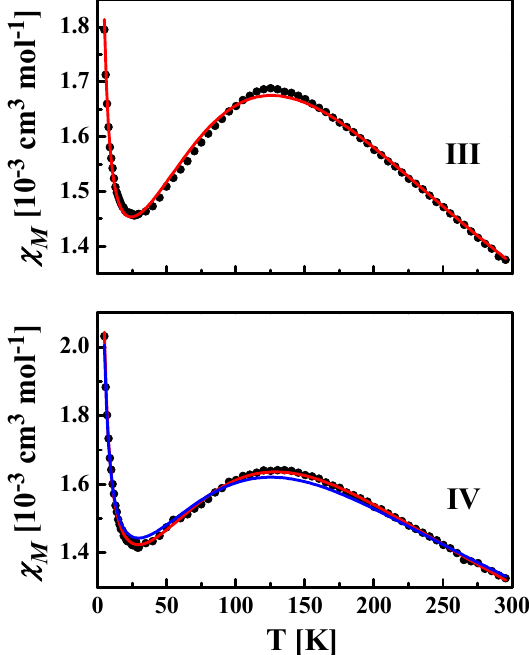
Figure 8. Temperature dependence of molar susceptibility χ III and IV at 0.1 T. Red solid lines are simulations based on the fitting procedure as discussed in the text. For IV the blue line corresponds to the fit obtained assuming zJ ' =